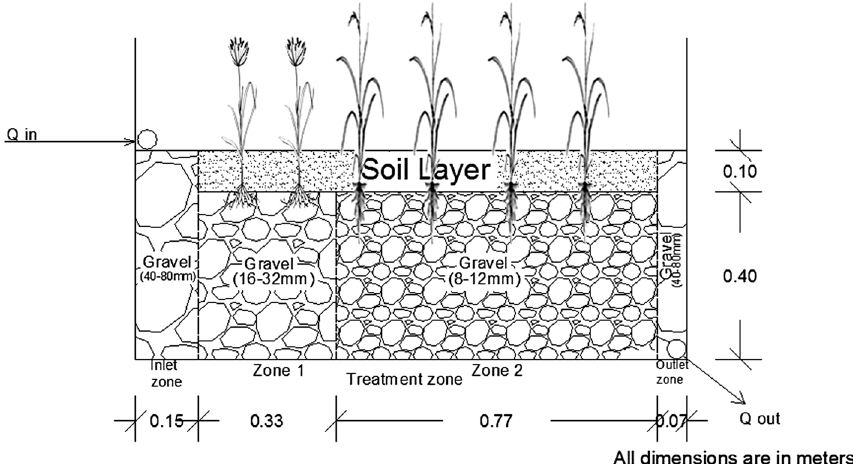
Fig. 2 Schematic representation of pilot-scale HSSF-CW